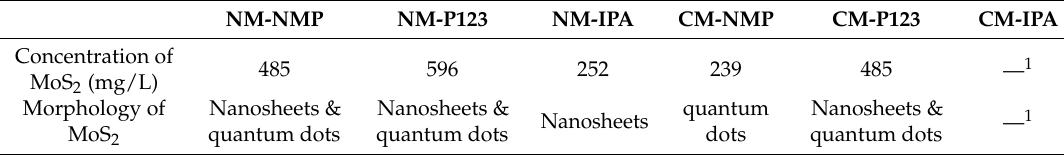
Table 1. The concentrations and morphologies of MoS 2